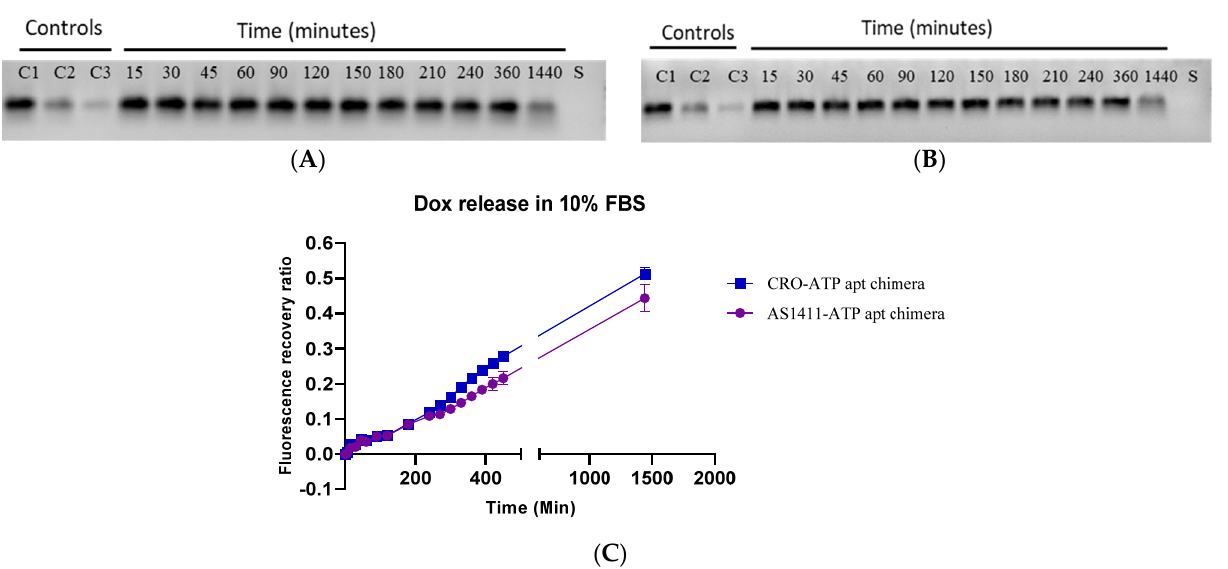
Figure 5. Serum stability assay of the generated chimeras. ( A ) Serum stability of AS1411–ATP chimera on gel electrophoresis. ( B ) Serum stability of CRO–ATP chimera on gel electrophoresis. The bands of chimera are shown in black in 2% agarose gel. The numbers at the top indicate the time of incubation with serum in minutes. C1 = 1 μ g of chimera, C2 = 0.5 μ g and C3 = 0.25 μ g used as control, S = serum blank. ( C ) Fluorescence recovery ratio of doxorubicin from both chimeras after incubation with 10% FBS.